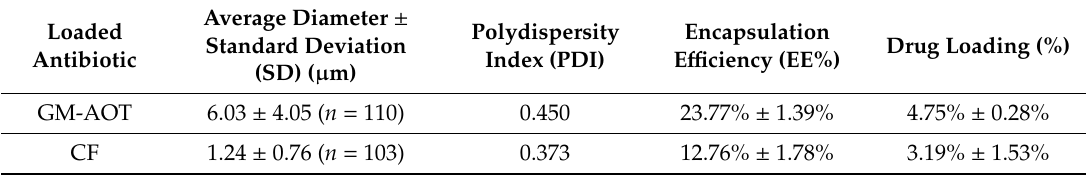
Table 1. Average size, polydispersity index (PDI), and antibiotic load characteristics of GM-AOT and CF loaded PCL / cPVA-ASP microspheres.